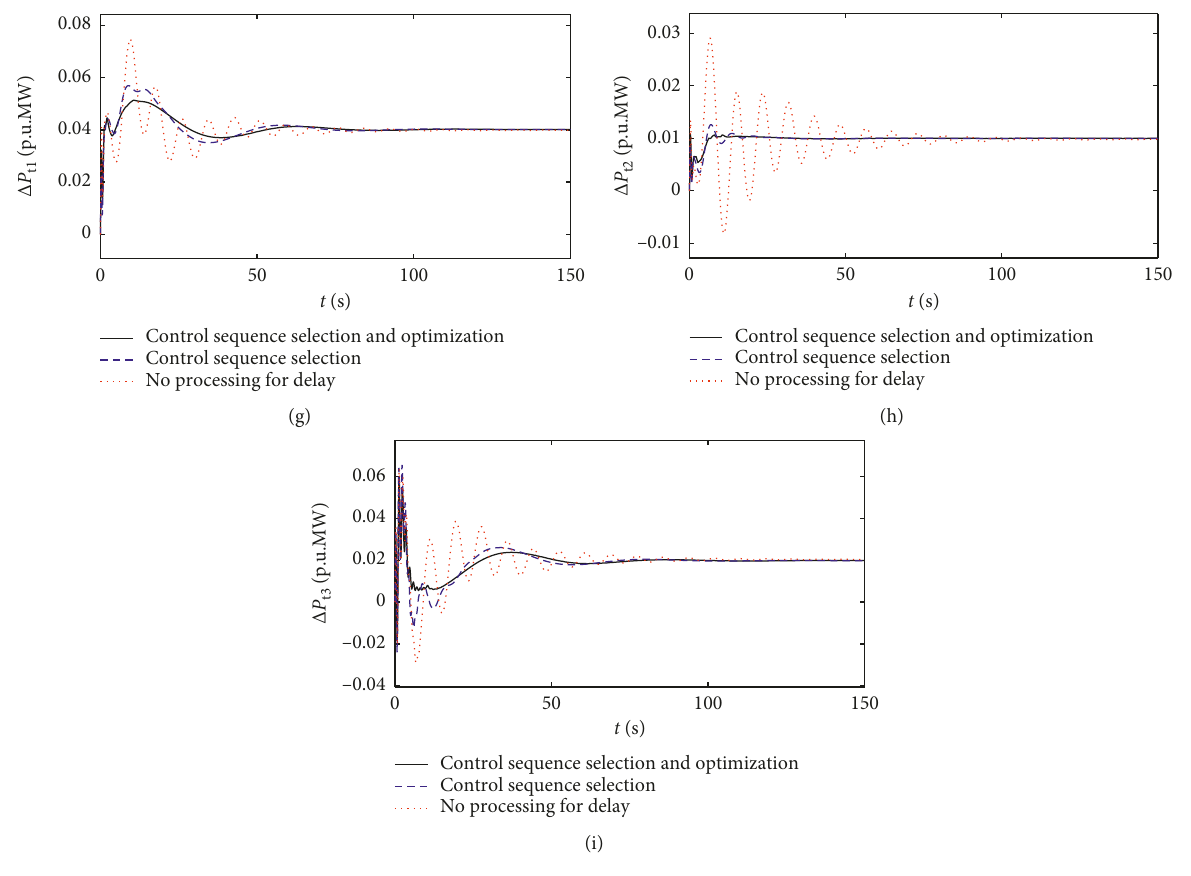
Figure 8: The step response curves. (a) ACE 1 response curve. (b) ACE 2 response curve. (c) ACE 3 response curve. (d) Δ f 1 response curve. (e) Δ f 2 response curve. (f) Δ f 3 response curve. (g) Δ P t1 response curve. (h) Δ P t2 response curve. (i) Δ P t3 response curve.